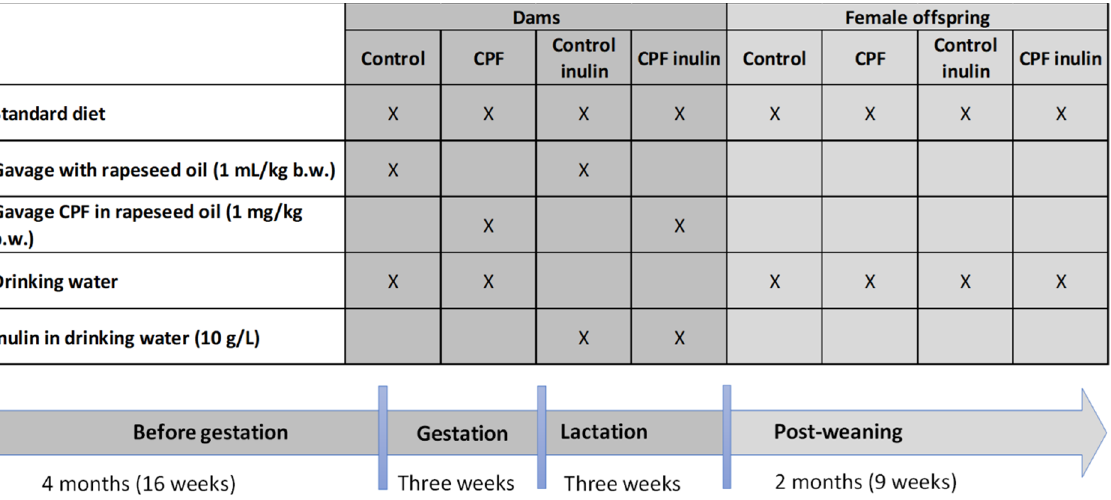
Figure 1. Treatment groups. Dams were fed standard diet and various treatments per os before gestation until weaning at which time they were sacrificed. Their female offspring were fed a standard diet only until 60 days of age at which time they were sacrificed. CPF: Chlorpyrifos; b.w.: body weight.